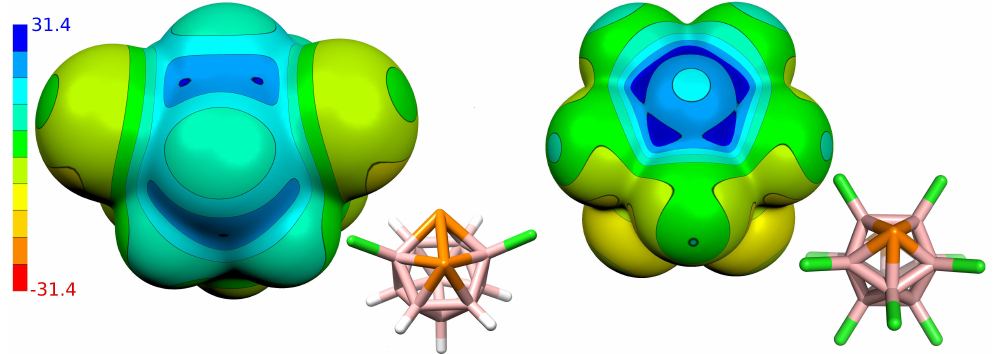
Figure 2. The computed molecular electrostatic potential (ESP) surface and molecular diagrams for 3,6-Cl 2 - closo -1,2-P 2 B 10 H 8 and closo -1,7-P 2 B 10 Cl 10 ; the color range of the ESP in kcal mol −1 .